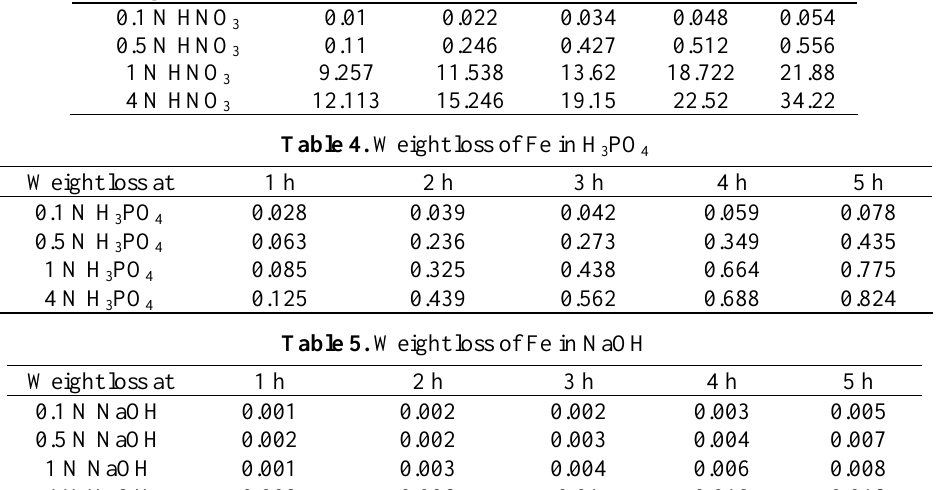
Table 3. Weight loss of Fe in HNO